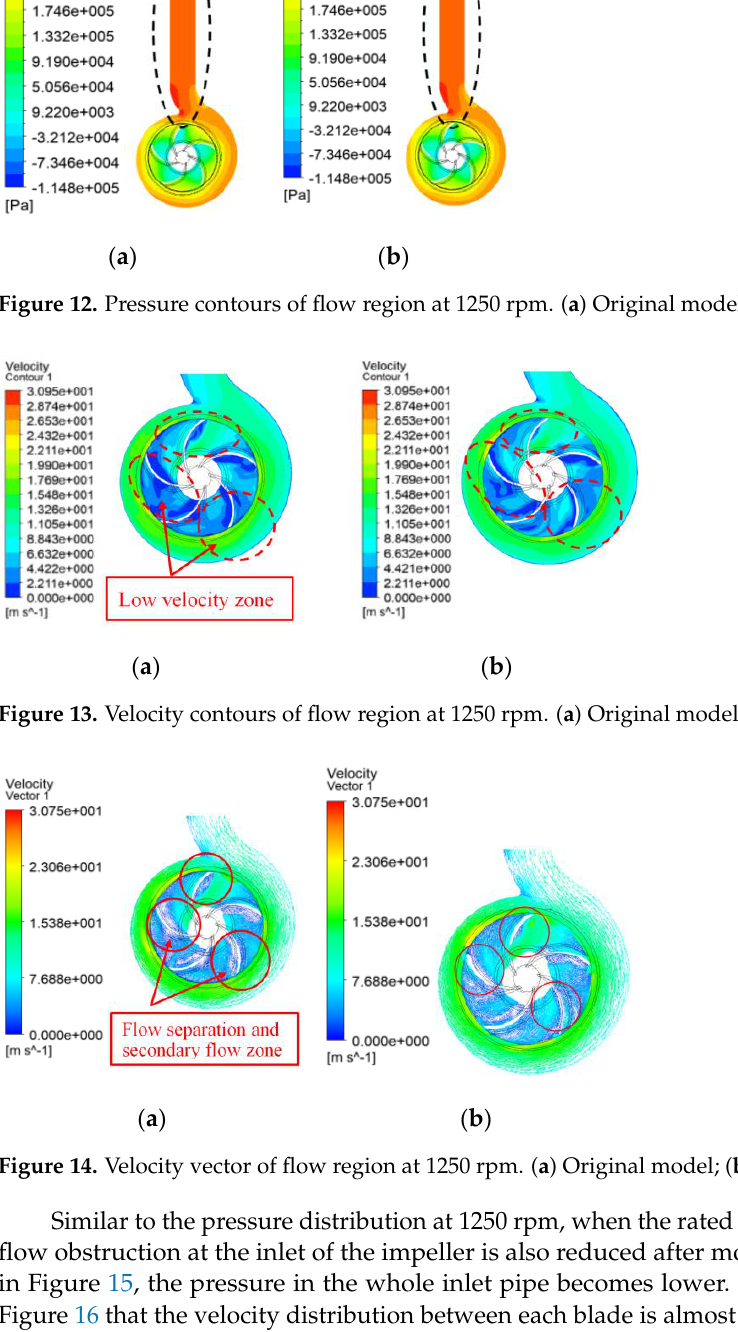
( b ) Figure 15. Pressure contours of flow region at 1500 rpm. ( a ) Original model; ( b ) rounded model.